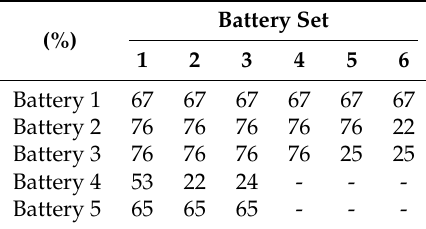
Table 1. Percentage values of battery actual capacity (from nominal value).